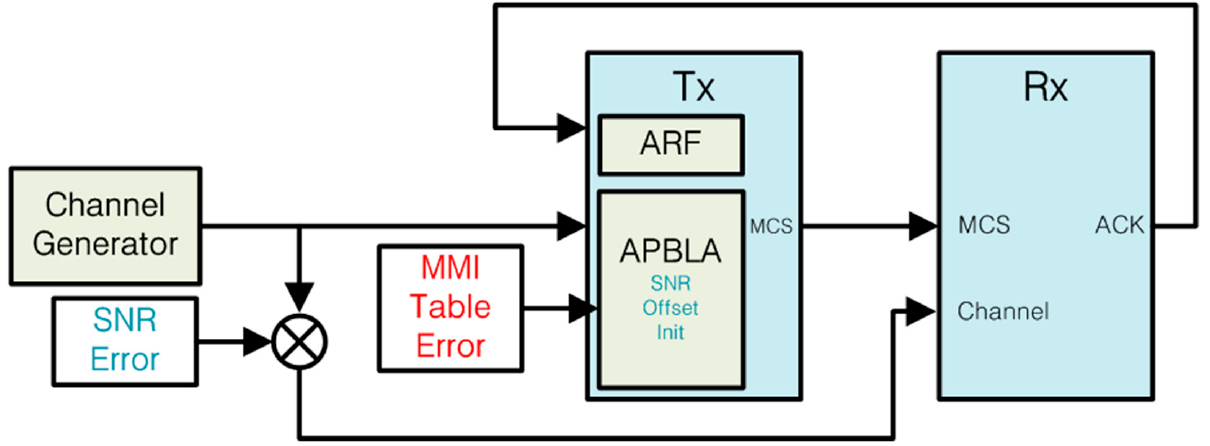
Figure 16. Simulation setup to identify the throughput gain of APBLA vs. ARF. Figure 17 plots the simulation results of the gain of APBLA against ARF. The x -axis is the normalized Doppler frequency. For instance, if the packet transmission interval is 1 ms and Doppler frequency is 1 Hz, the normalized Doppler frequency is 1 m, which is defined the product of the packet transmission interval and Doppler frequency. The y -axis is the throughput that is measured from ACKs stochastically produced with respect to the calculated PER in the RX model. The blue line is for ARF, the grey line for ILA, and the red line for APBLA. Here, ILA means the link adaptation model where the most ideal MCS is selected according to the received channel information. As the channel information is acquired from the preamble of the previous packet, 1 packet delay is reflected in any events. Three-tap Rayleigh fading is assumed as to MCS 0–7 in IEEE 802.11n. Also, the MMI table errors corresponding to the left half of Figure 7 are considered. From Figure 17, it is identified that when the normalized Doppler frequency increases, the throughput for ARF is heavily aggravated. On the other hand, the throughput for APBLA only modestly deteriorates as the normalized Doppler frequency grows. When the throughput gain of APBLA over ARF is maximized or equivalent when the normalized Doppler frequency is 50 m (say, when the packet transmission interval is 10 ms for a 5 Hz Doppler frequency), the ARF throughput is 24 Mbps and the APBLA throughput is 31 Mbps, yielding a throughput gain of around 30% for APBLA against